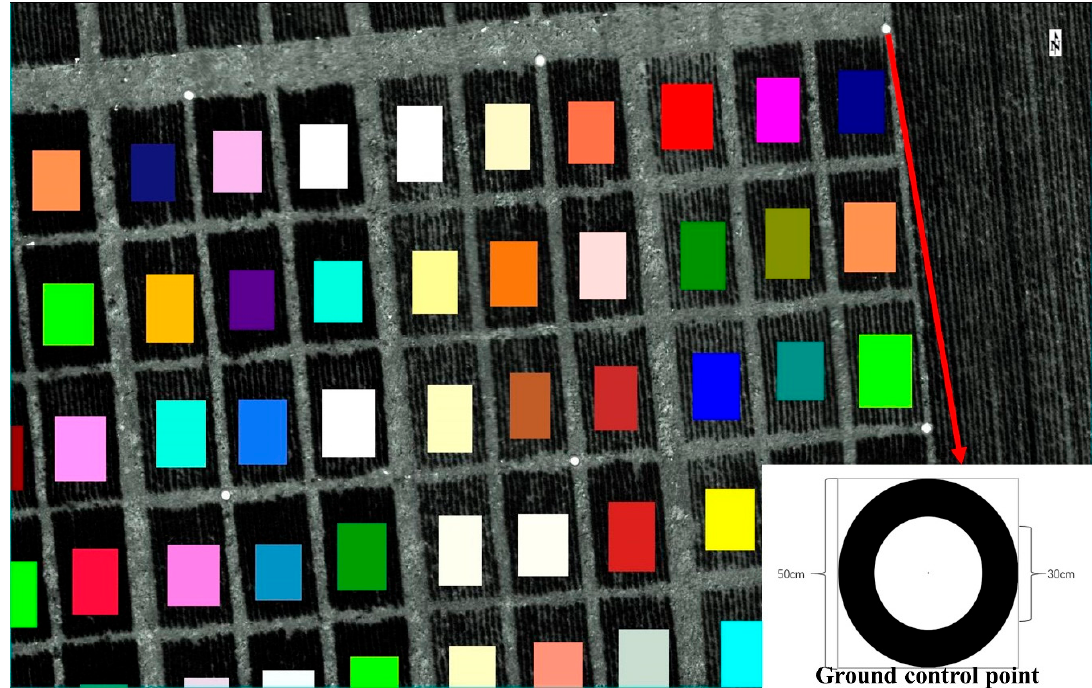
Figure 2. Region of interest and one of the ground control points.